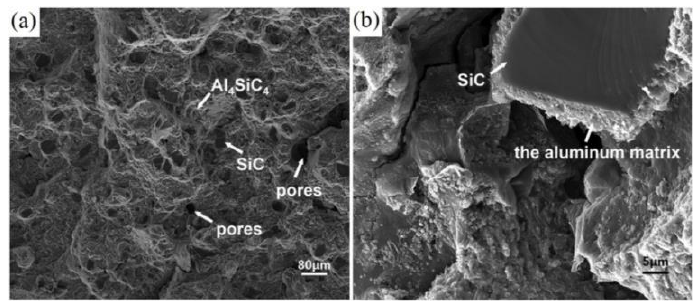
Figure 16. ( a ) and ( b ) Fracture surface of the SLM-processed 15 wt.% SiC / AlSi10Mg composite system subjected to tensile testing showing un-reacted SiC particles and porosities [74].